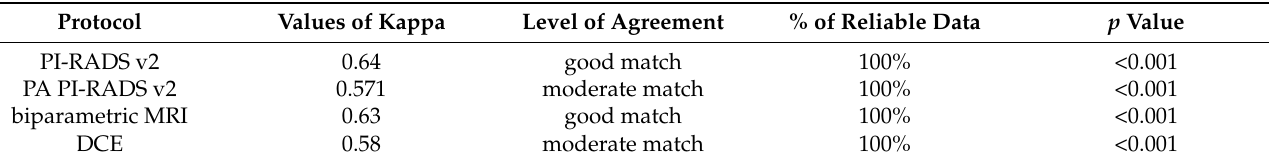
Table 4. The values of Kappa of inter-observer agreement.